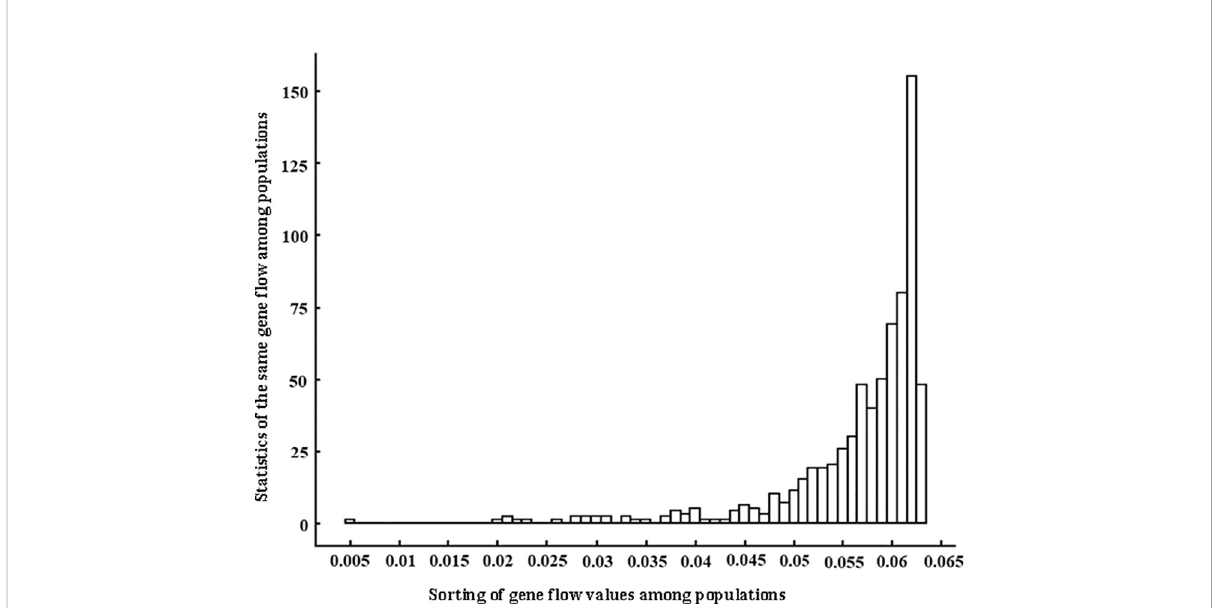
FIGURE 1 Distribution of gene fl ow values among 38 populations of Wikstroemia monnula based on twelve microsatellite loci. The horizontal axis is sorted in gene fl ow value orders from low to high, and the vertical axis is total number of gene fl ow with the same